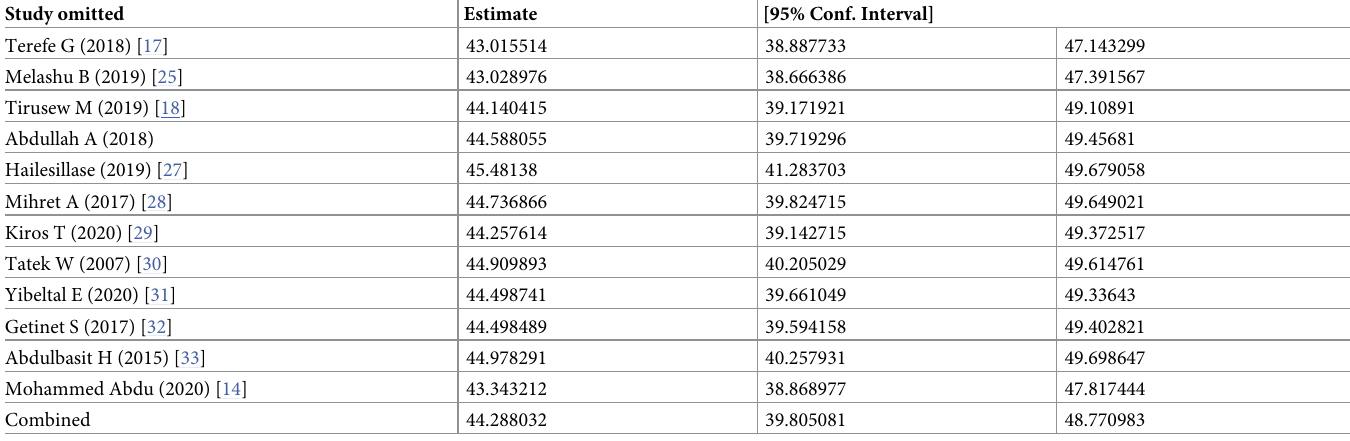
Table 3. Sensitivity analysis of pooled prevalence for each study being removed one at a